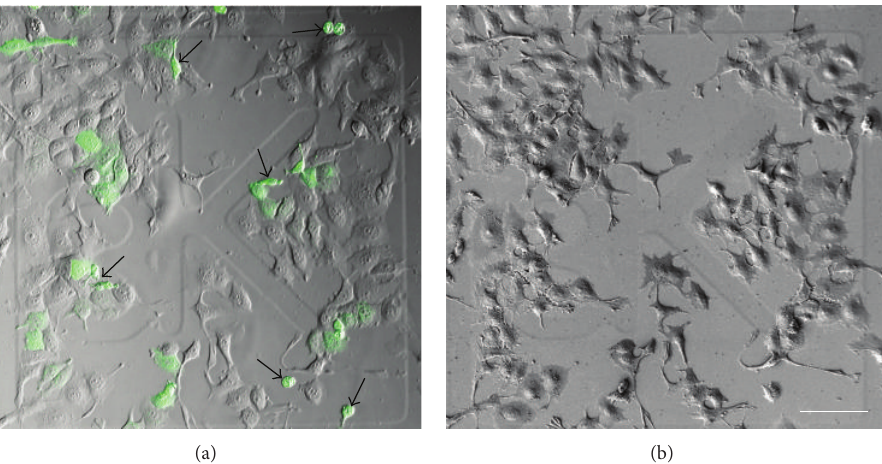
Figure 1: Utilization of gridded coverslips for localization of cultured cells for correlative imaging. Low magnification images showing an overview of transiently transfected cells imaged by CLSM and DIC (a) and the corresponding area imaged by SEM (b). Arrows in (a) indicate cells that were detached in the subsequent preparation steps for scanning electron microscopy. Scale bar 100 𝜇